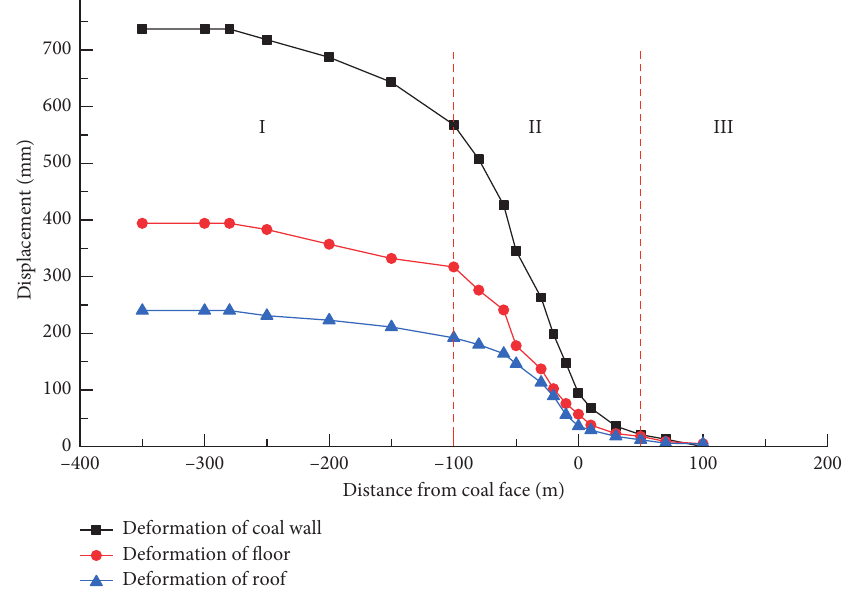
Figure 4: Deformation of the surrounding